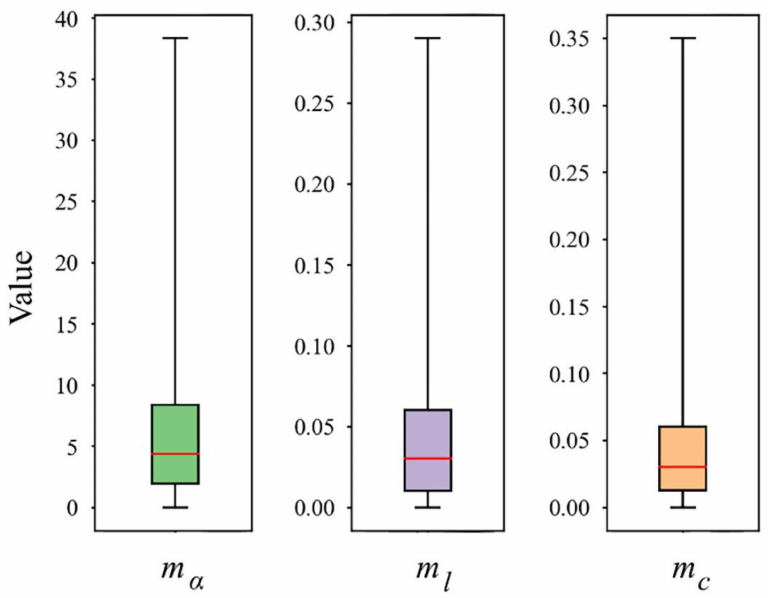
Figure 17. Boxplots of angle, length, and compactness comparison measures for all of the zones.